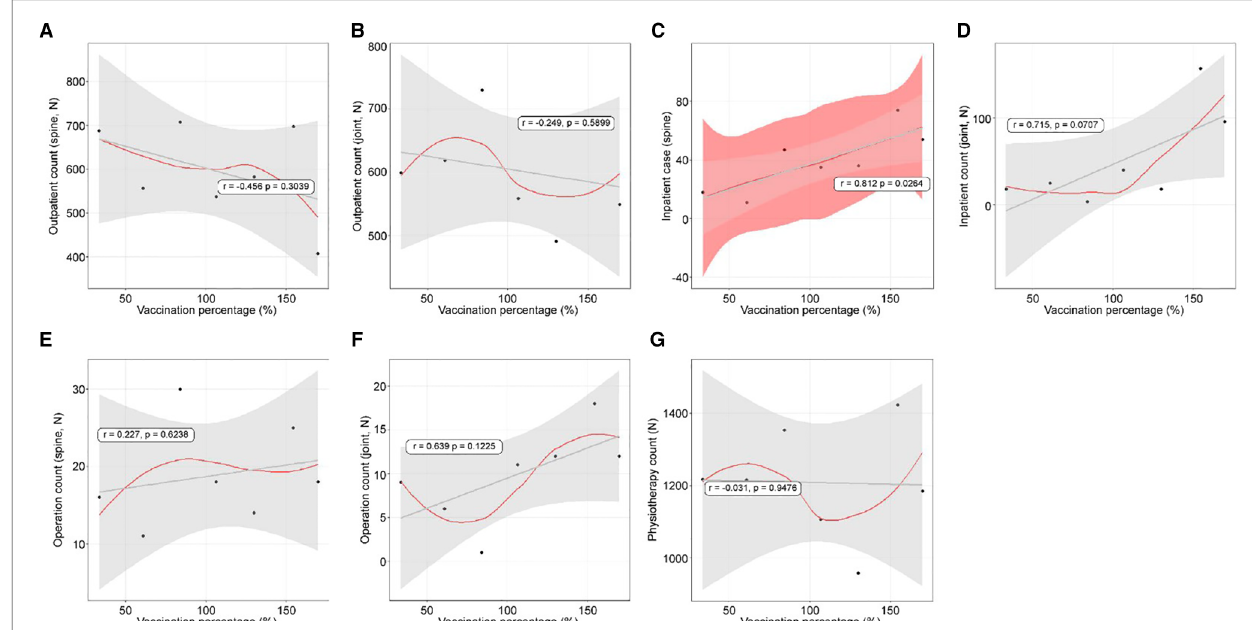
FIGURE 6 | The linear relationships between vaccination rate and orthopedic hospital visiting patterns. ( A ) Spine outpatient count; ( B ) Joint outpatient count; ( C ) Spine inpatient count; ( D ) Joint inpatient count; ( E ) Spine operation patient count; ( F ) Joint operation patient count; ( G ) Physiotherapy patient